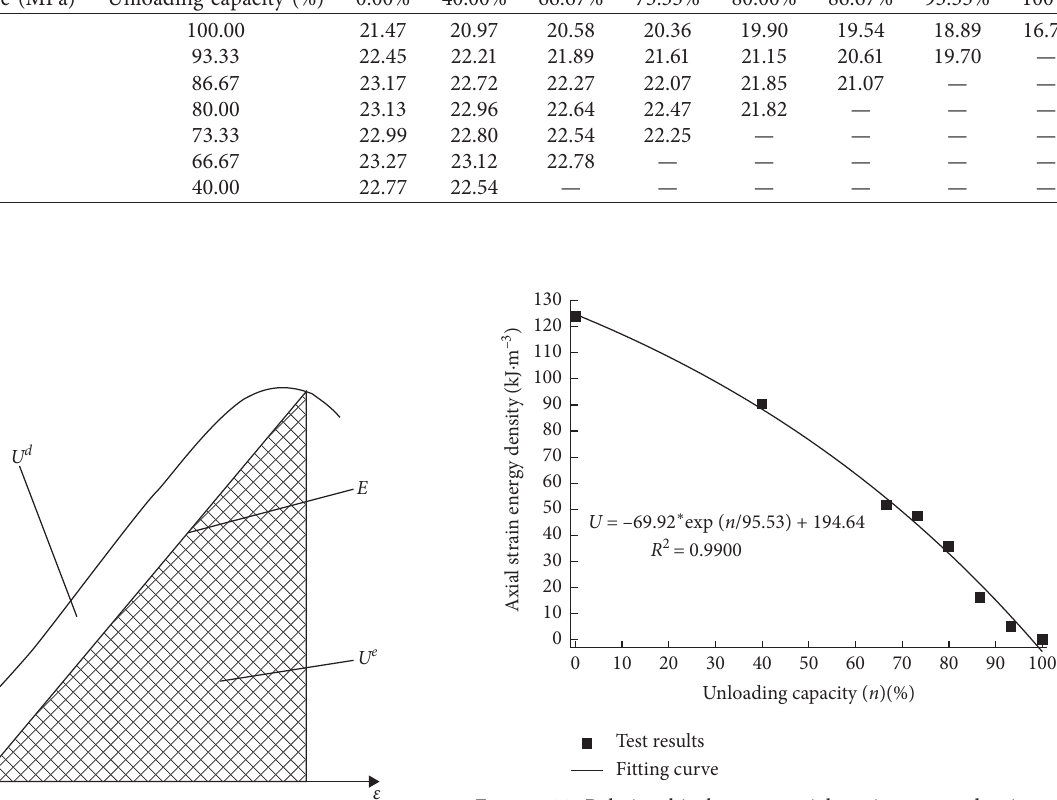
Figure 11: Relationship between axial strain energy density and unloading